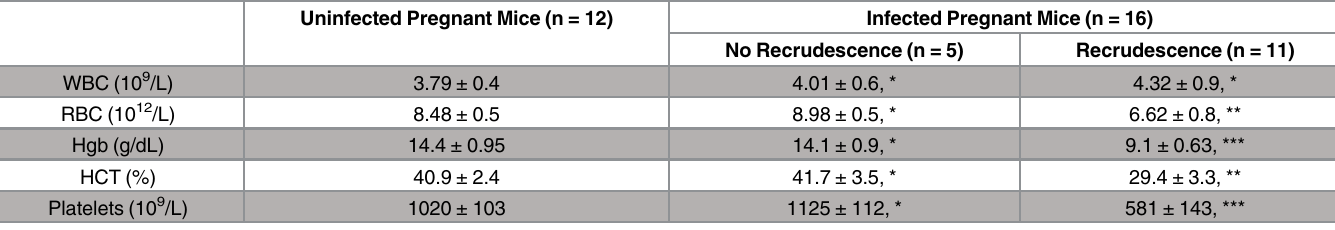
*** p < 0.0001. Infected mice (n = 16) received Pcc- CB sporozoites and were then paired with males 35 days post-inoculation; age-matched mice that had not been infected (n = 12) were paired with males simultaneously. Hematological parameters, including white blood cell (WBC) count, red blood cell (RBC) count, hemoglobin (Hgb) level, hematocrit (HCT), and platelet count were measured. Data are presented as means ± SD. P values were calculated using Welch ’ s unpaired t- test, comparing subgroups of infected mice to uninfected